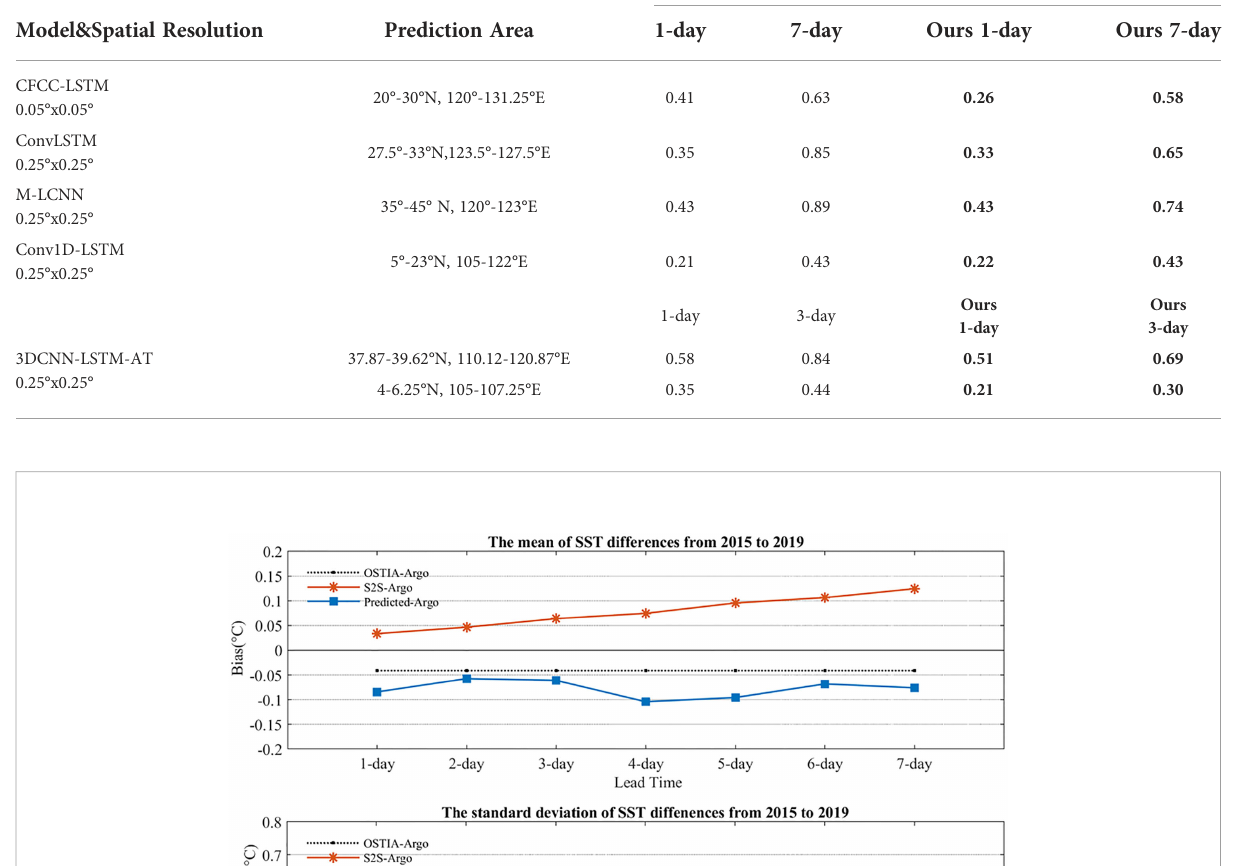
TABLE 4 The comparison with other deep learning-based models in different sea areas.